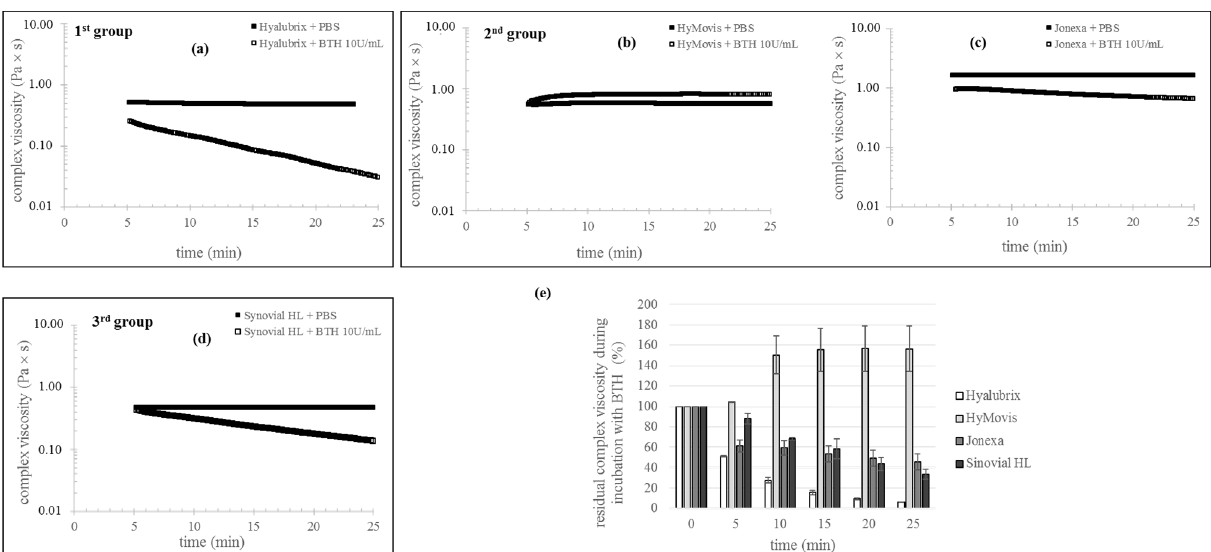
Figure 3. Degradation during incubation with BTH 10 U/mL for the gels ( a ). Reduction in complex viscosity during 25 min incubation with BTH 10 U/mL for the 1st group gel ( a ), the 2nd group gels ( b , c ) and the 3rd group formula ( d ). For each gel, the complex viscosity values recorded during incubation with PBS, measured under the same conditions (control), are also reported. Residual complex viscosity (% with respect to the control) at 5, 10, 15, 20, and 25 min of incubation with the enzyme ( e ). The value at time zero (control) is also reported. All measurements were performed at 37 °C, 2% strain and 2.5 Hz frequency.